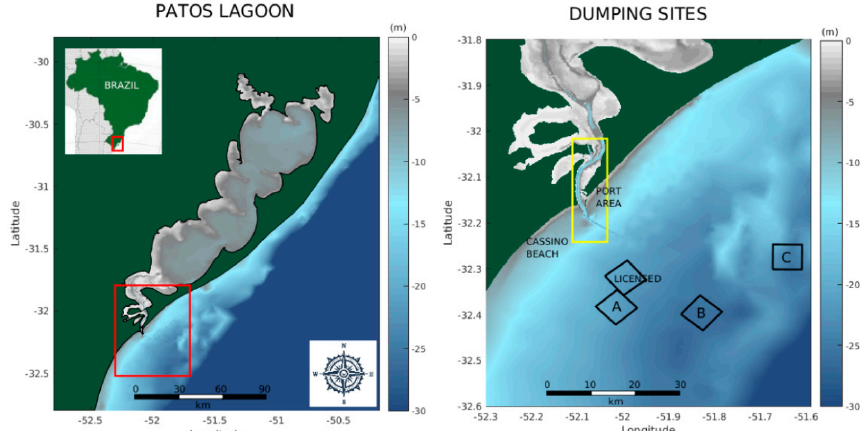
Figure 1. Left panel—Patos Lagoon, the Port of Rio Grande, and Cassino Beach. Right panel— Zoomed-in view of the Patos Lagoon estuary, where the squares indicate the position of the existing licensed disposal site and the alternative disposal sites investigated in this study (Sites A, B, C). Current bathymetric data were provided by the Brazilian Navy and Rio Grande Port Authority and interpolated for the